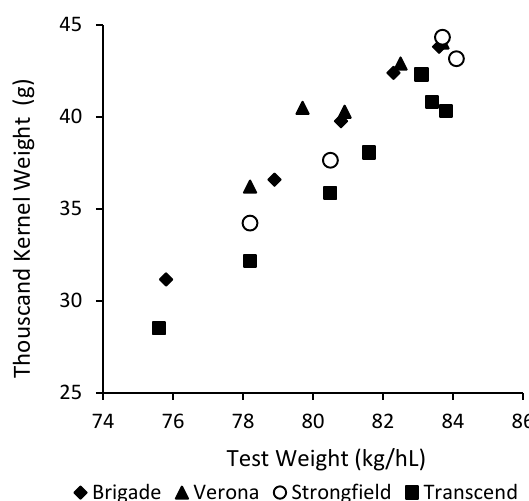
Figure 2. Inter-relationship between test weight and thousand kernel weight of varietal composites in sample set II.